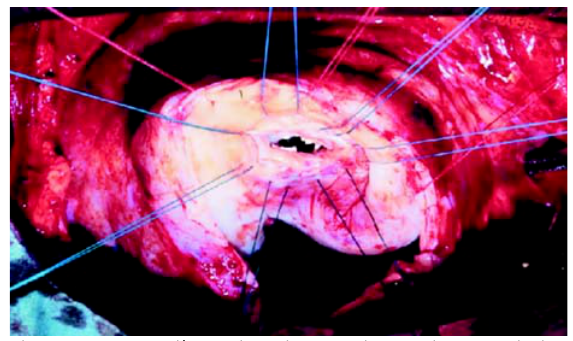
Fig. 4 – Rotura cardíaca subaguda. “Pseudo-aneurisma ventricular” tratamento